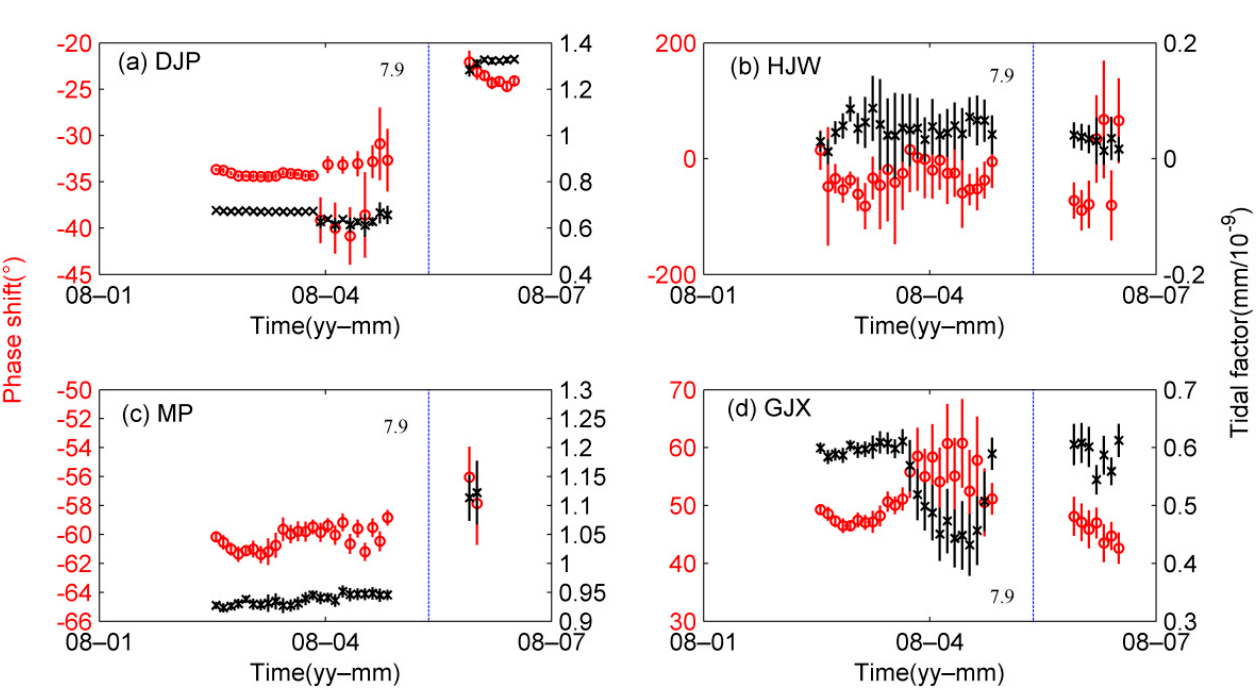
Figure 5. Tidal responses before and after the Wenchuan earthquake. The dotted line represents the origin time of the earthquake.